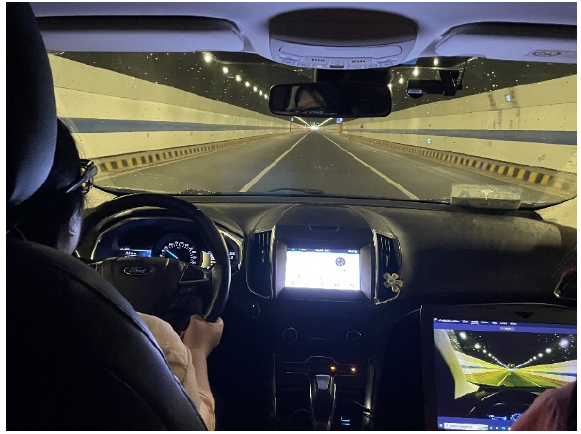
Figure 2. Experiments of actual driving.